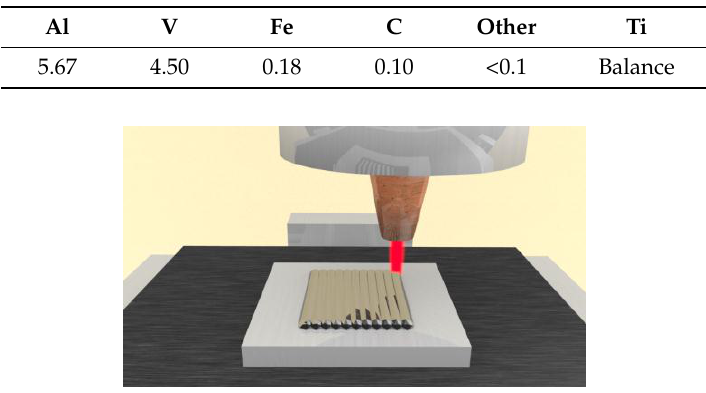
Figure 1. Scheme of the setup used to perform the LR treatments on Ti 6 Al 4 V samples.